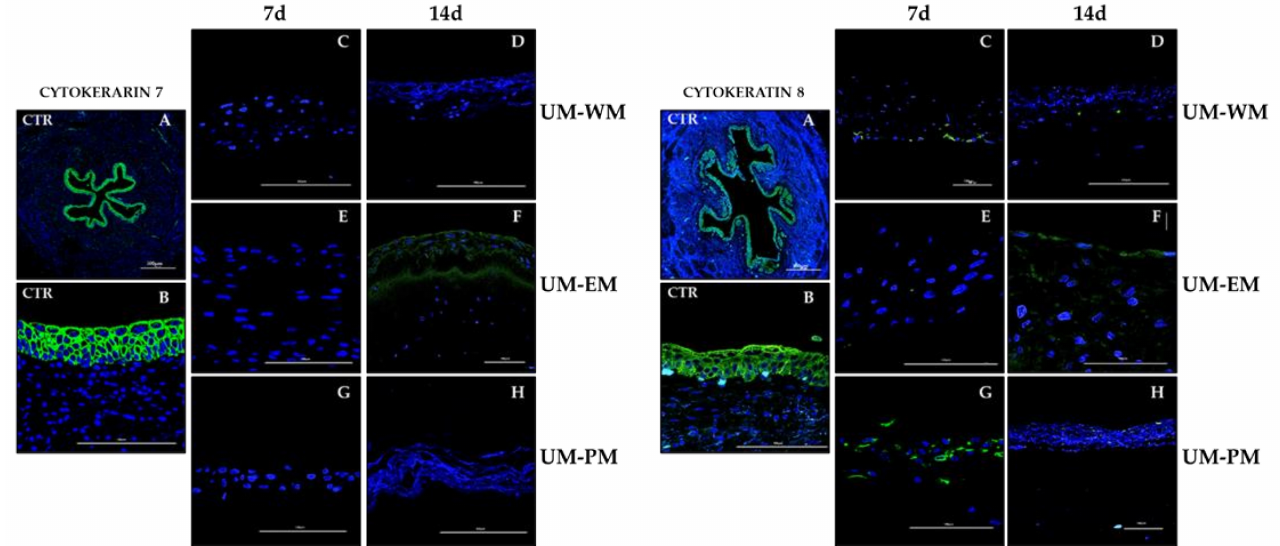
Figure 6. Immunofluorescence analysis of cytokeratins 7 and 8 in control human UM (CTR) and tubularized heterotypical substitutes of the human UM cultured with three different media (WM, EM, and PM) for 7 and 14 days. Scale bars: 500 µ m in ( A ) and 100 µ m in ( B – H ) panels.